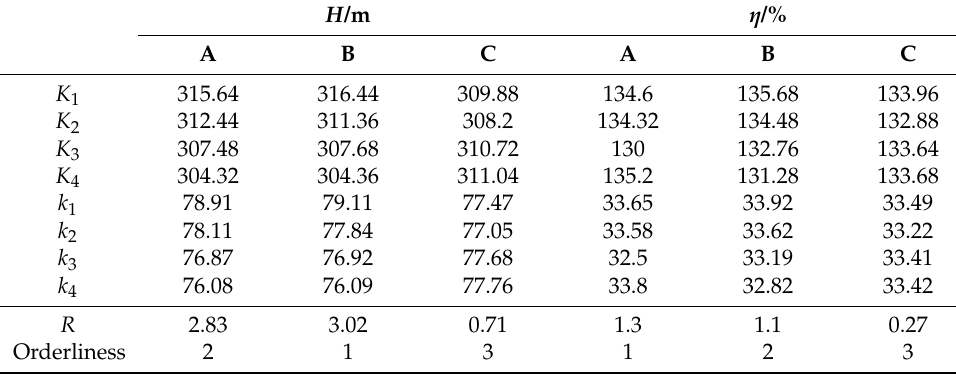
Table 10. Range analysis of the head and efficiency at 1.4 Q des .